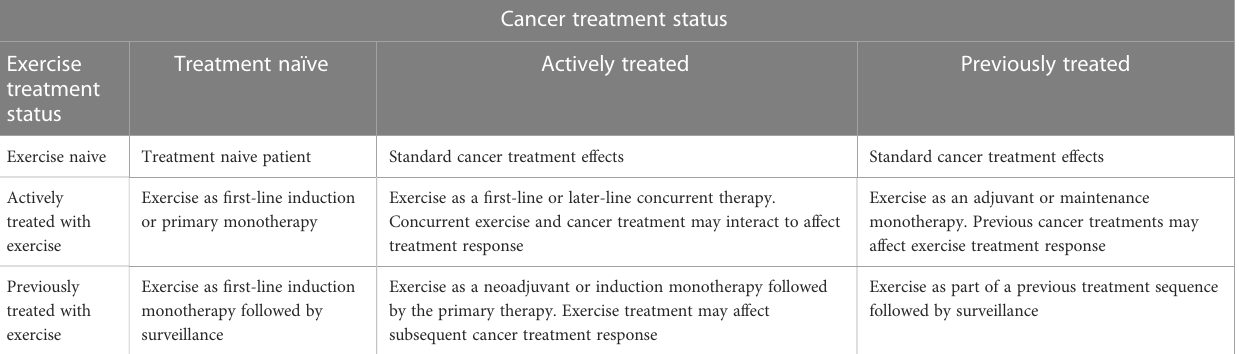
TABLE 2 Exercise treatment status as part of the cancer treatment